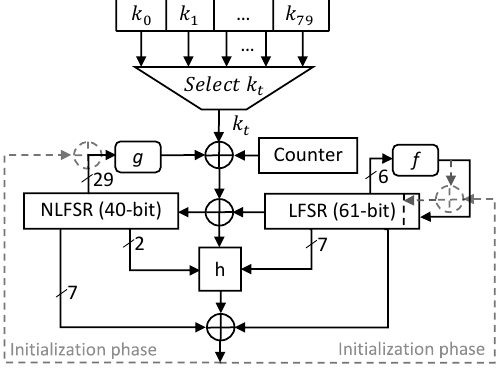
Figure 1: The Structure of Plantlet